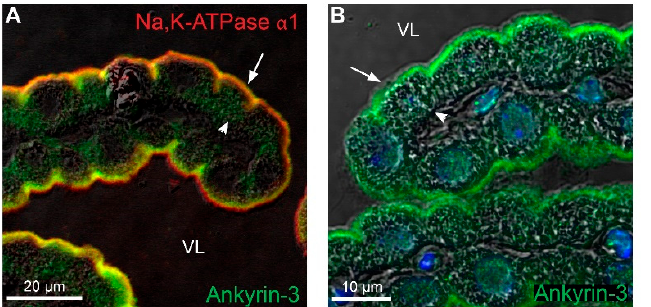
Figure 9. Immunolocalization of ankyrin-3 in the CPE. ( A ) Double immunofluorescence labeling for Na,K-ATPase α 1 (red) and ankyrin-3 (green) in the CPE. ( B ) Immunofluorescence labeling for ankyrin-3 (green) overlaid on the corresponding DIC image. Arrows indicate luminal surfaces, while arrowheads mark basolateral surfaces. VL denotes the fourth ventricle lumen.